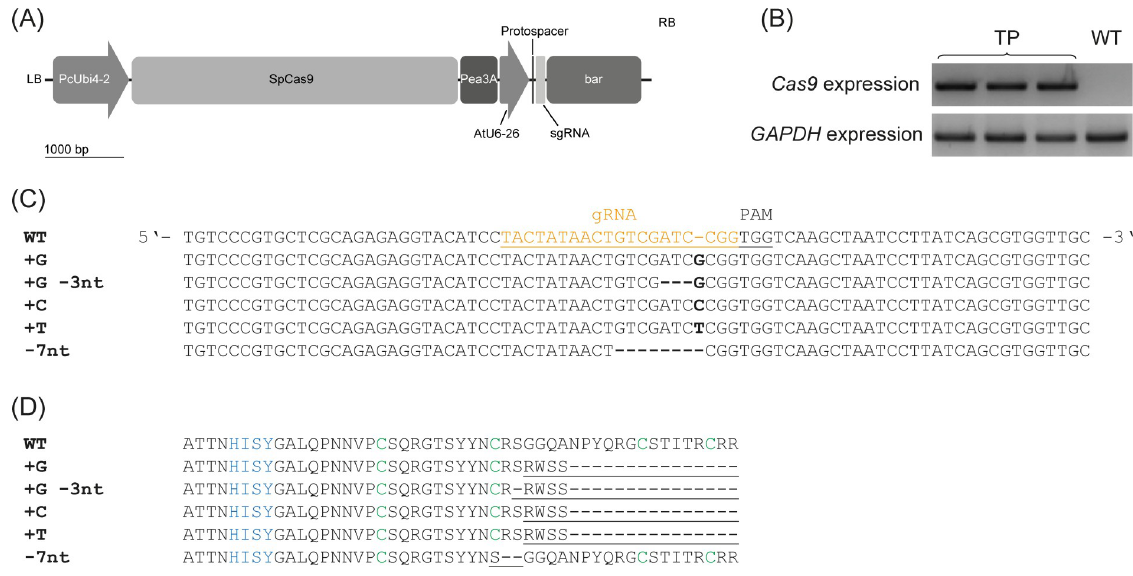
Fig 4. Mutation analysis of the TkRALFL1 CRISPR/Cas9 plants. (A) Schematic depiction of the TkRALFL1-CRISPR/Cas9 construct. PcUbi4-2, Ubiquitin4-2 promoter from Petroselinum crispum ; SpCas9, Cas9 nuclease from Streptococcus pyogenes ; Pea3A, pea3A terminator from Pisum sativum ; AtU6-26, U6-26 promoter from Arabidopsis thaliana ; sgRNA, single-guide RNA; bar , phosphinothricin resistance cassette from pFGC5941 vector; LB, left border; RB, right border. (B) Analysis of the cas9 expression in the transgenic T0 plants and a wild- type control. The housekeeping gene glycerine aldehyde-3-phosphate dehydrogenase ( GAPDH ) was amplified as a control. TP, transgenic T0 plants; WT, wild-type control plant. (C) Nucleotide alignment of sequencing results from the T0 generation, showing the section around the CRISPR target site for different observed mutations. Sequences were obtained by amplification of the complete TkRALFL1 sequence, followed by transfer to the TOPO sequencing vector. The protospacer adjacent motif (PAM) is underlined; the protospacer is underlined and orange; mutations are highlighted in bold letters or with dashes and are listed on the right side. (D) In silico analysis of the deduced amino acid sequences resulting from the mutations induced by CRISPR/Cas9, showing the mature peptide sequence. Sequences were aligned using MUSCLE algorithm. The YISY motif is highlighted in blue, the conserved cysteine residues are highlighted in green, and amino acids affected by the frameshift introduced by the mutations are underlined.